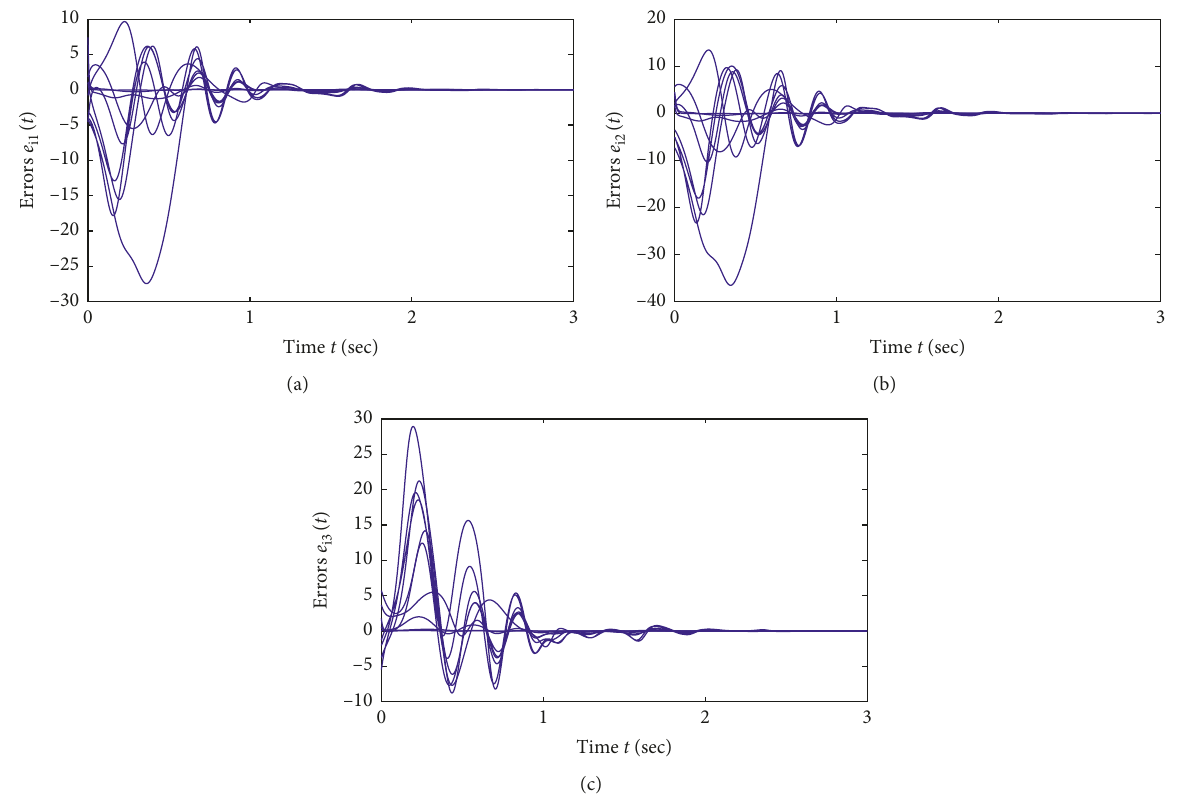
( i � 1 , 2 , . .. , 10 ) . (b) e i 1